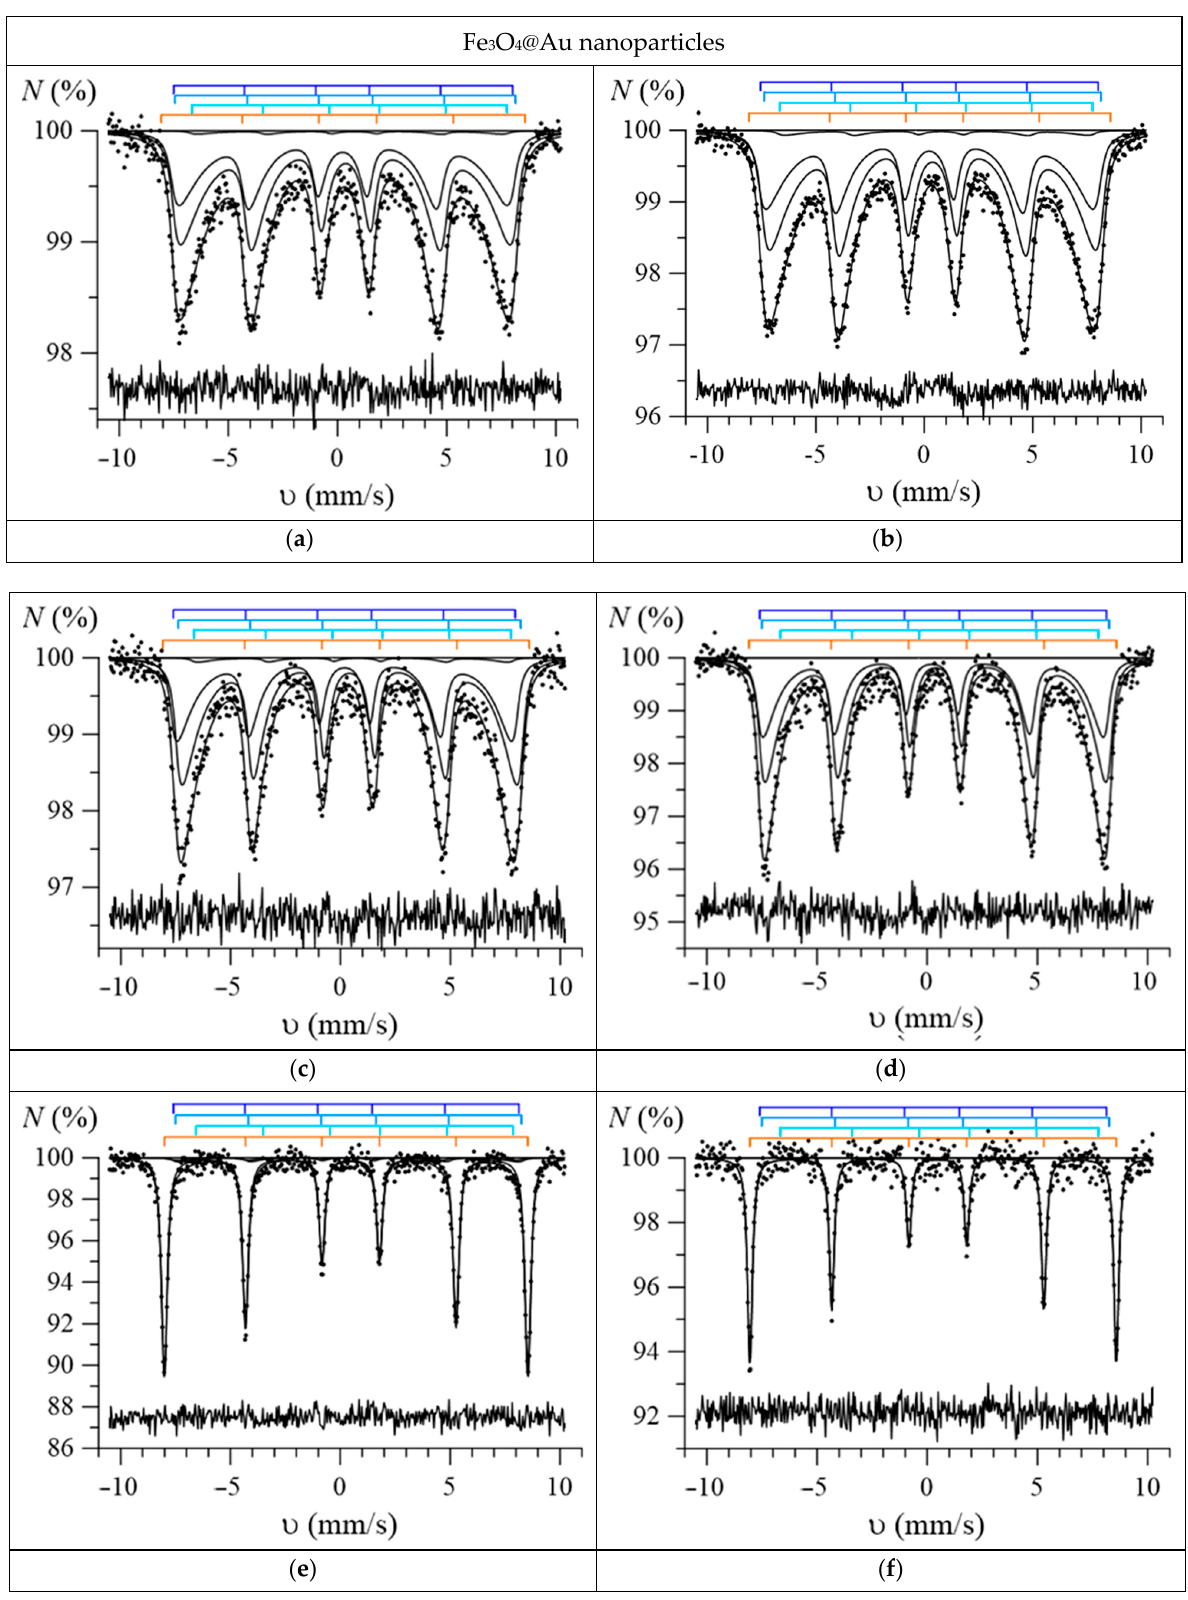
Figure 8. Mössbauer spectra of the initial ( a ) and annealed at temperatures of 100 °C ( b ), 200 °C ( c ), 400 °C ( d ), 600 °C ( e ), 800 °C ( f ) Fe 3 O 4 nanoparticles (on each spectrum the positions of the resonance lines of the subspectra used for model fitting are shown; the lines corresponding to magnetite are shown in blue, and the lines corresponding to hematite are shown in orange).